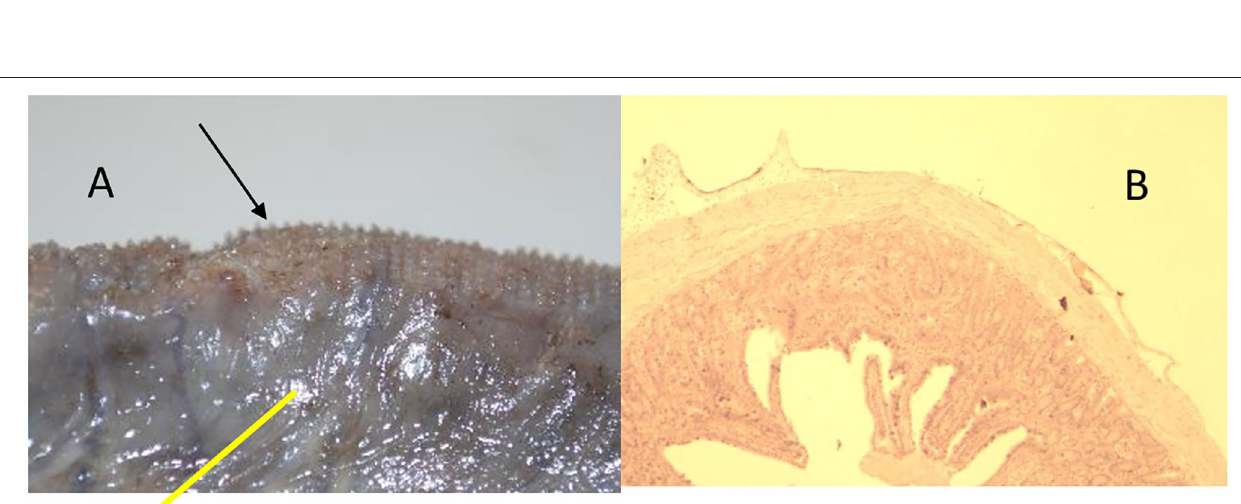
FIGURE 7 | Animal 1, − 80 mmHg. (A) Colon resection. Section after removing the patch with a paving stone-shaped pattern (arrows). Non-patch area with a smooth surface (yellow bar). (B) Colon wall from the “Patch” section. Superficially with extension consisting of serosa and subserosa. Underlying wall layers without pathological